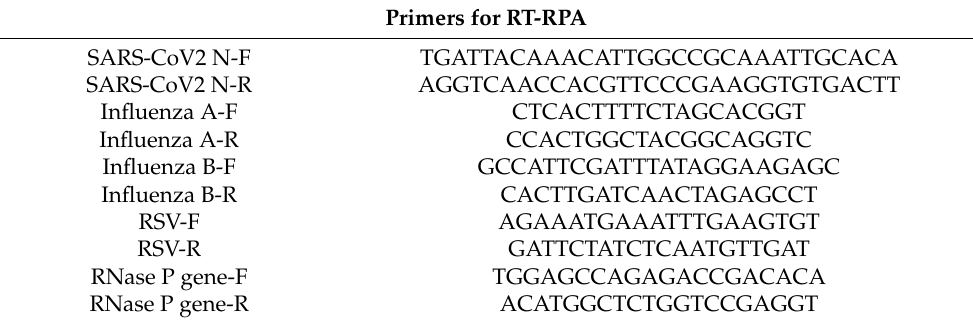
Table 1. Sequences for RPA